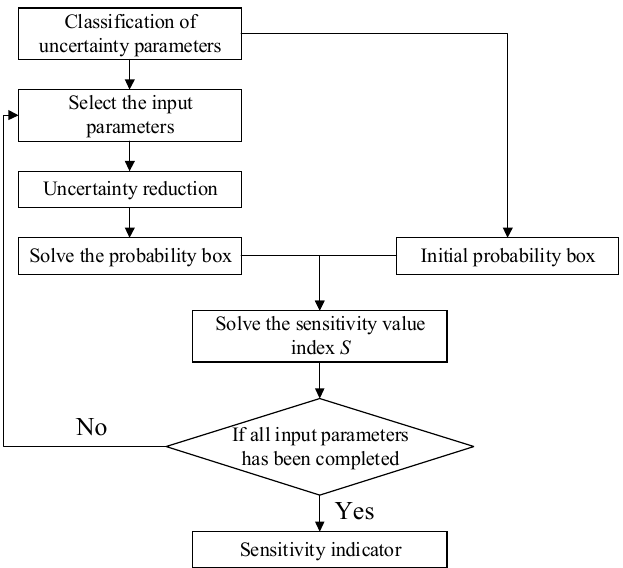
Figure 7. Flowchart of the pinching method for probability box sensitivity analysis.